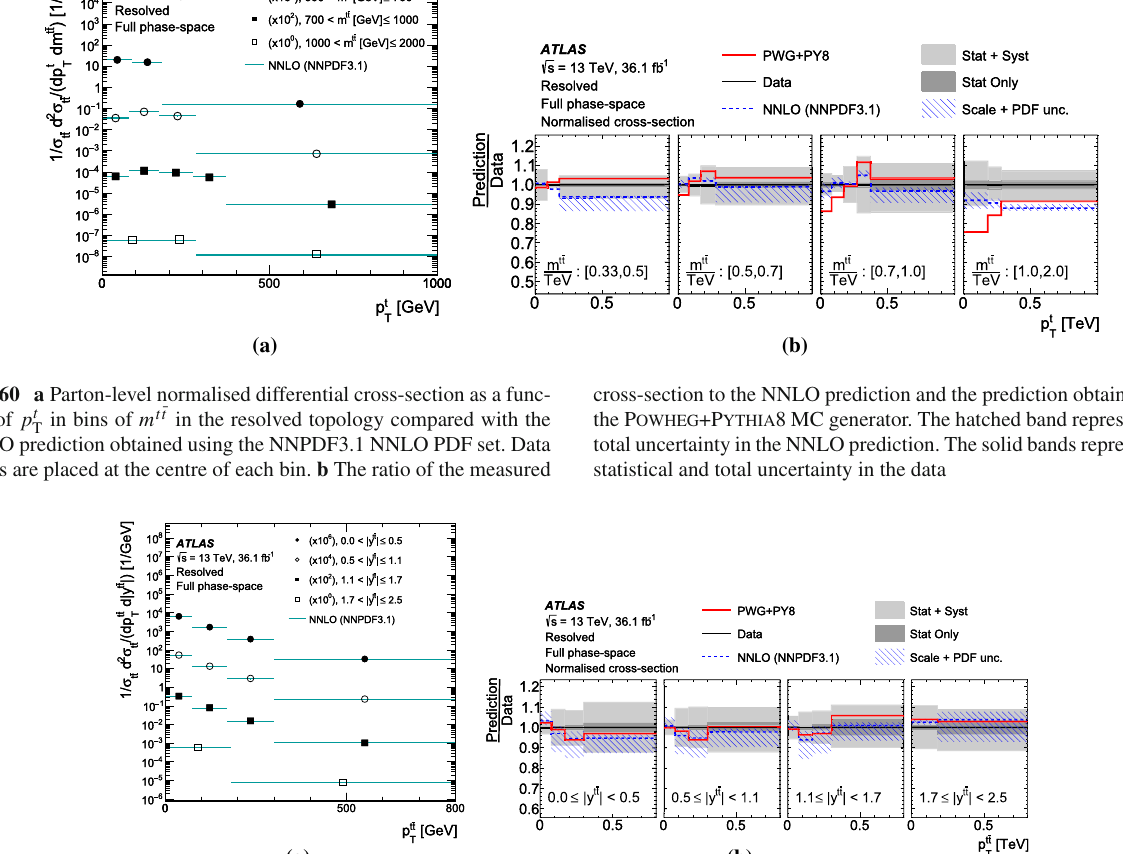
cross-section to the NNLO prediction and the prediction obtained with the Powheg + Pythia8 MC generator. The hatched band represents the total uncertainty in the NNLO prediction. The solid bands represent the statistical and total uncertainty in the